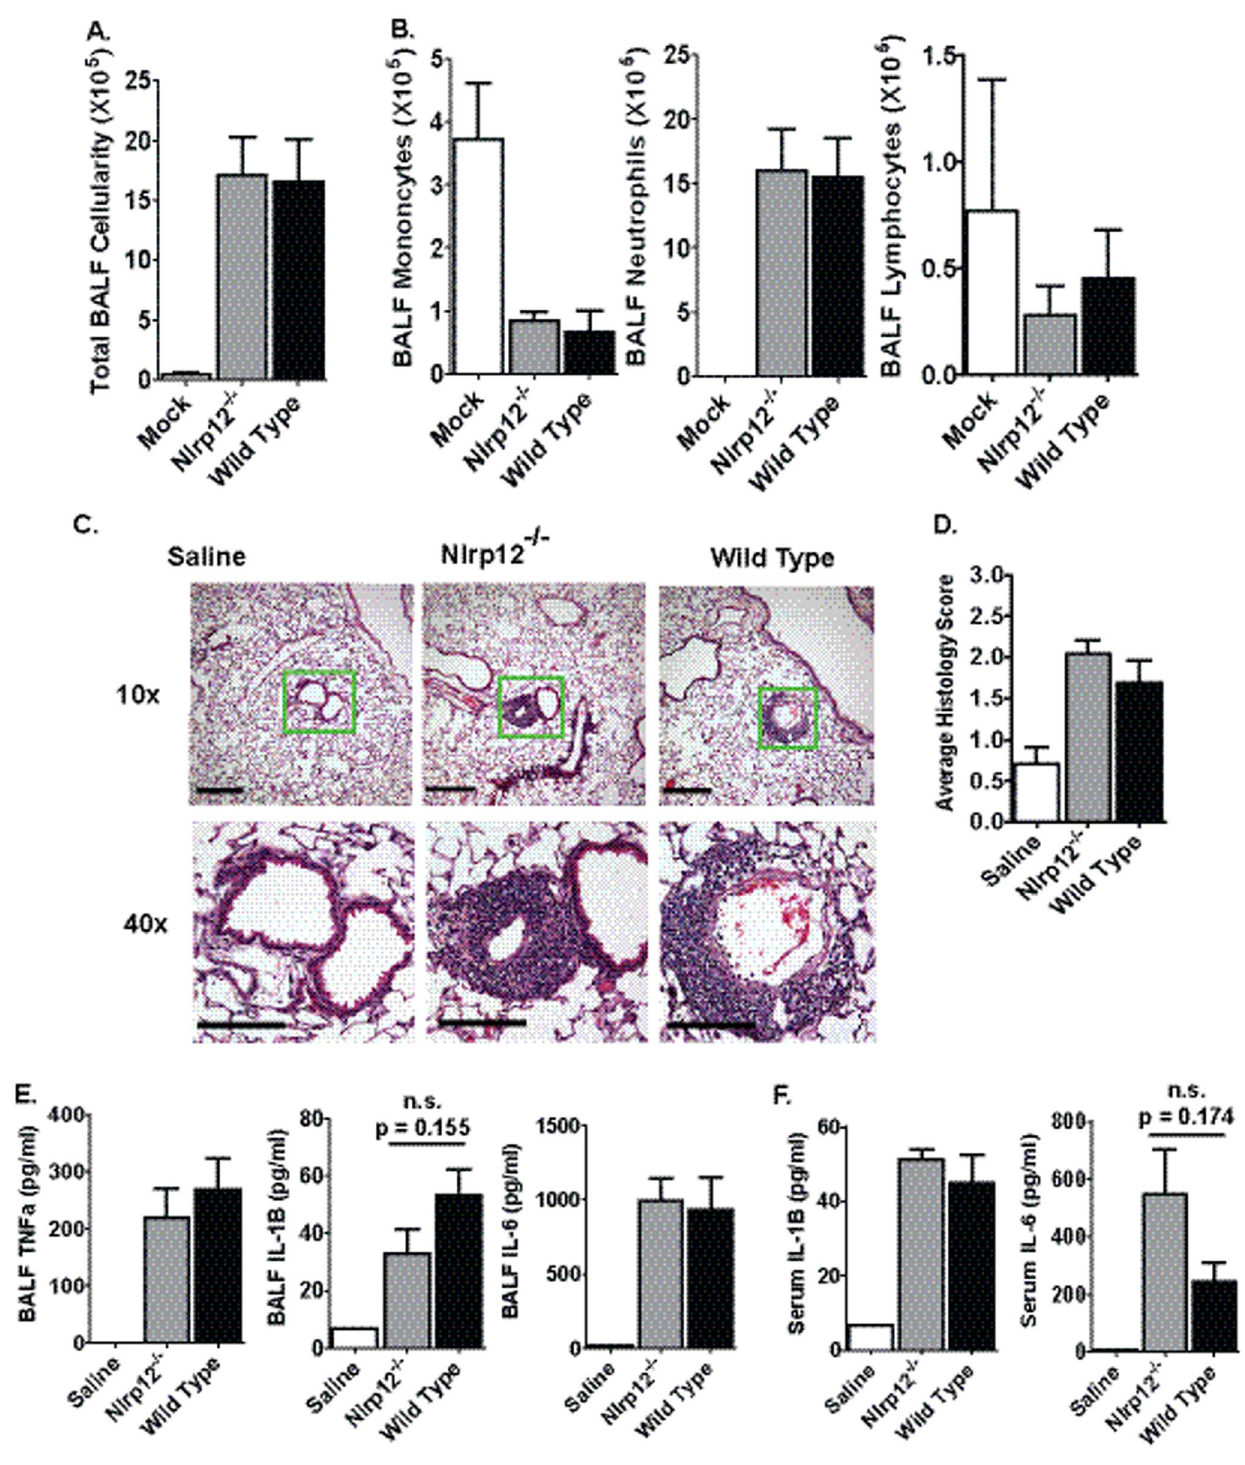
Figure 2. LPS mediated acute airway inflammation in Nlrp12 2 / 2 mice. Mice were challenged with 1 mg/kg of E. coli LPS (serotype 0111:B4) i.t. and airway inflammation was assessed 48 hours post-challenge. A) LPS induced a significant increase in BALF cellularity. B) No significant differences were detected in the cellular composition of the BALF between Nlrp12 2 / 2 and wild type mice. C) Airway challenge with LPS resulted in a significant influx of neutrophils to the airway. Histopathology revealed a significant amount of perivascular and peribroncholar cuffing and some slight alveolar occlusion following lung LPS exposure. The magnification bar at 10 6 =10 m M and 40 6 =5 m M. D) Histopathology analysis and histology scoring revealed no significant differences between the Nlrp12 2 / 2 and wild type mice. E–F) LPS induced a significant increase in local (BALF) and systemic (serum) levels of proinflammatory cytokines. No significant differences were observed between Nlrp12 2 / 2 and wild type mice. Saline, n=3; LPS- treated Nlrp12 2 / 2 , n=6; LPS-treated Wild Type, n=6. Experiments were repeated 3 separate times with the same numbers of mice in each replicate.